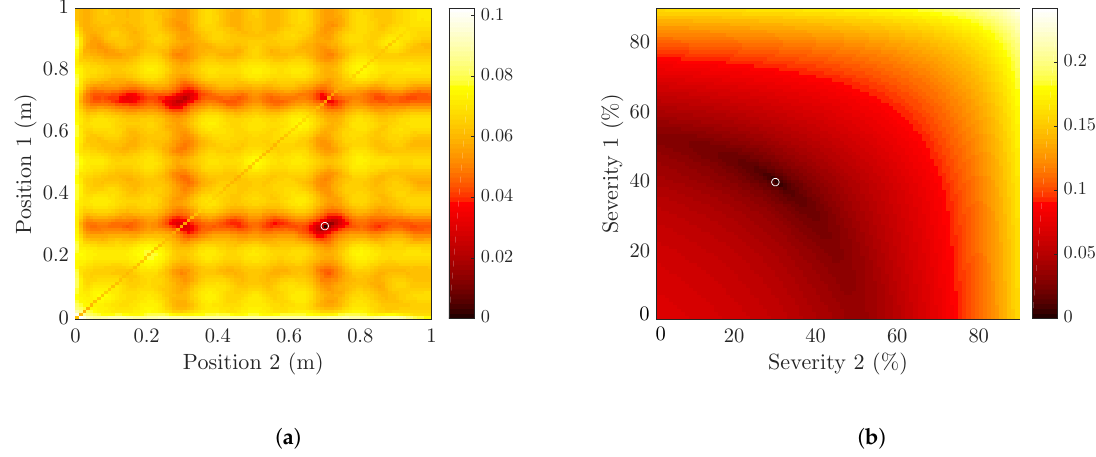
Figure 11. FSC as a function of tested multiple damage positions and severities ( a ) the white circle indicates that damage positions are 0.30 m and 0.70 m, ( b ) and severities of localized damage are 40% and